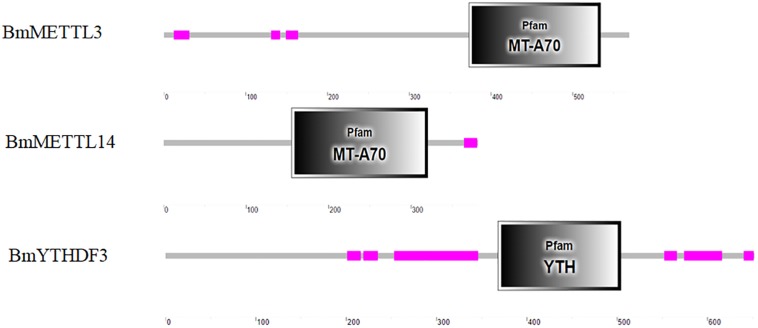
Analysis of conserved domains analysis of BmMETTL3, BmMETTL14, and BmYTHDF3 with the SMART software.